Question: Provide a publication-style caption for this figure.
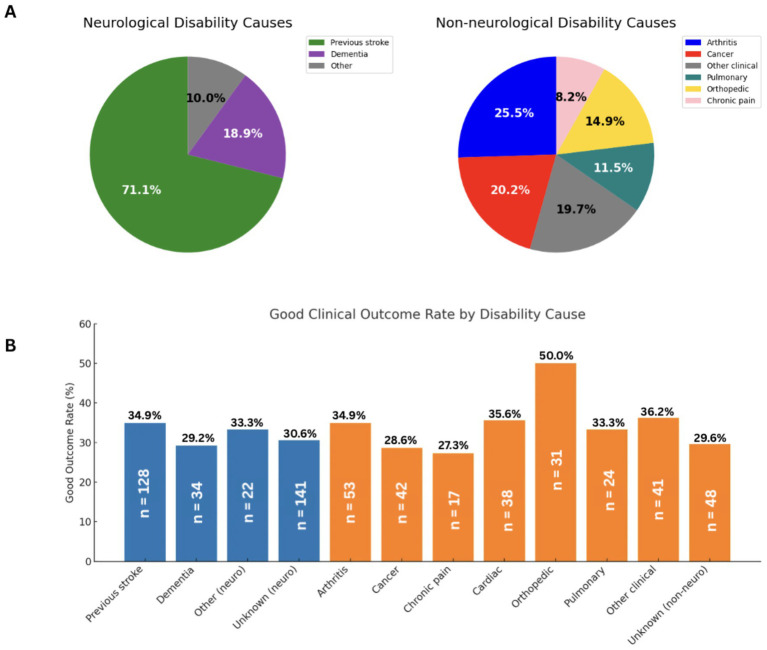
Answer: (A) Distribution of disability etiologies among patients with neurological and non-neurological causes of pre-stroke disability. (B) Rate of favorable clinical outcome according to specific disability etiology.